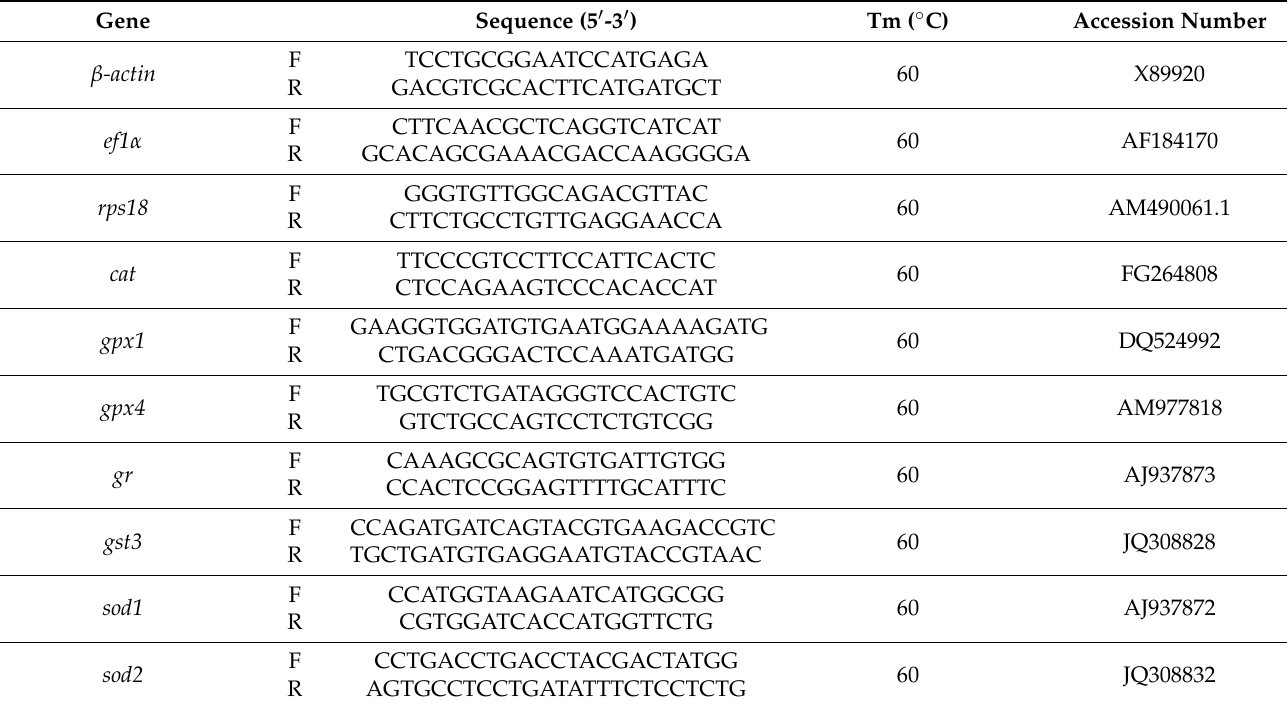
Table 3. Primers used for real-time qPCR: gene name, sequence, annealing temperature (Ta) and GenBank accession numbers.